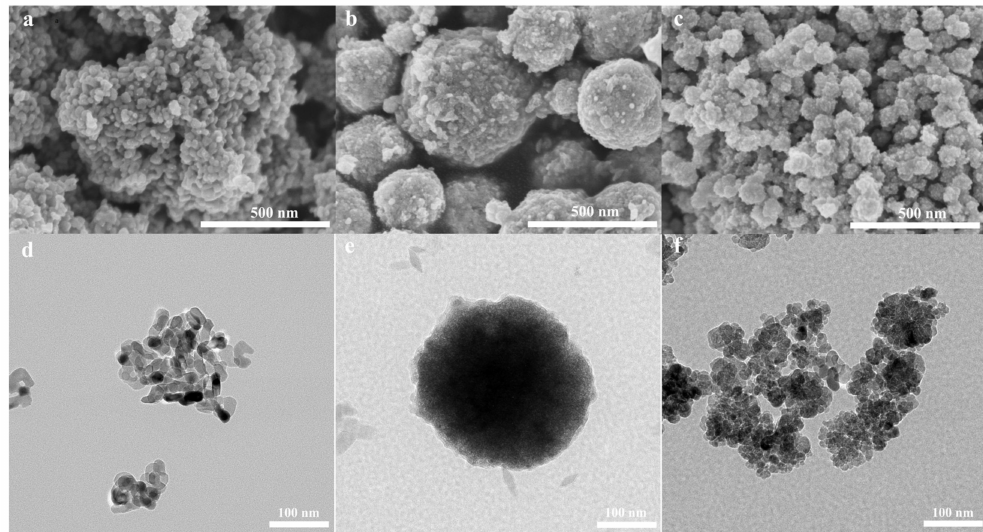
Figure 2. Scanning electron microscope (SEM) and transmission electron microscope (TEM) morphologies of TiO 2 − Ag